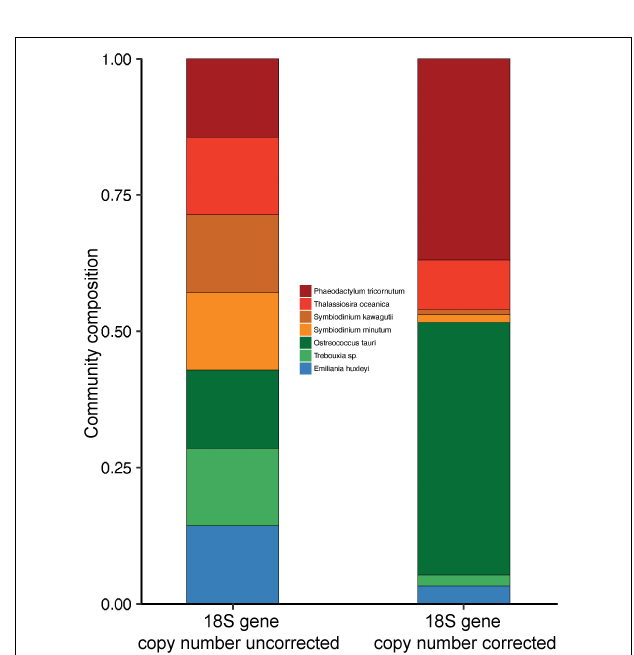
FIGURE 2 | Composition of a simulated phytoplankton community with equal sequence abundance from seven phytoplankton species before and after 18S gene copy number correction. Correction is based on 18S gene copy number estimates from this